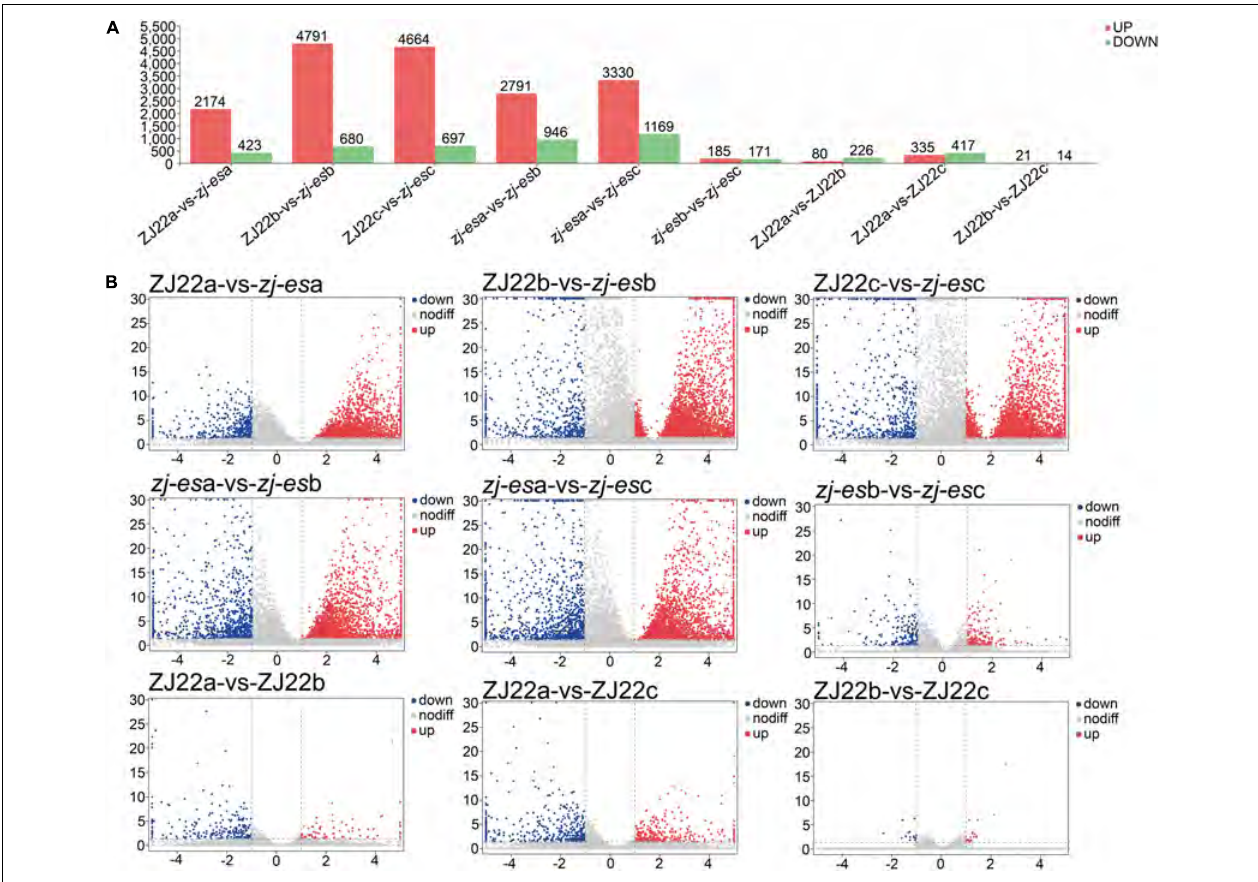
FIGURE 3 | Analysis of differentially expressed mRNAs in each comparison group. (A) The number of significantly regulated genes. (B) Volcano plots of mRNAs expression